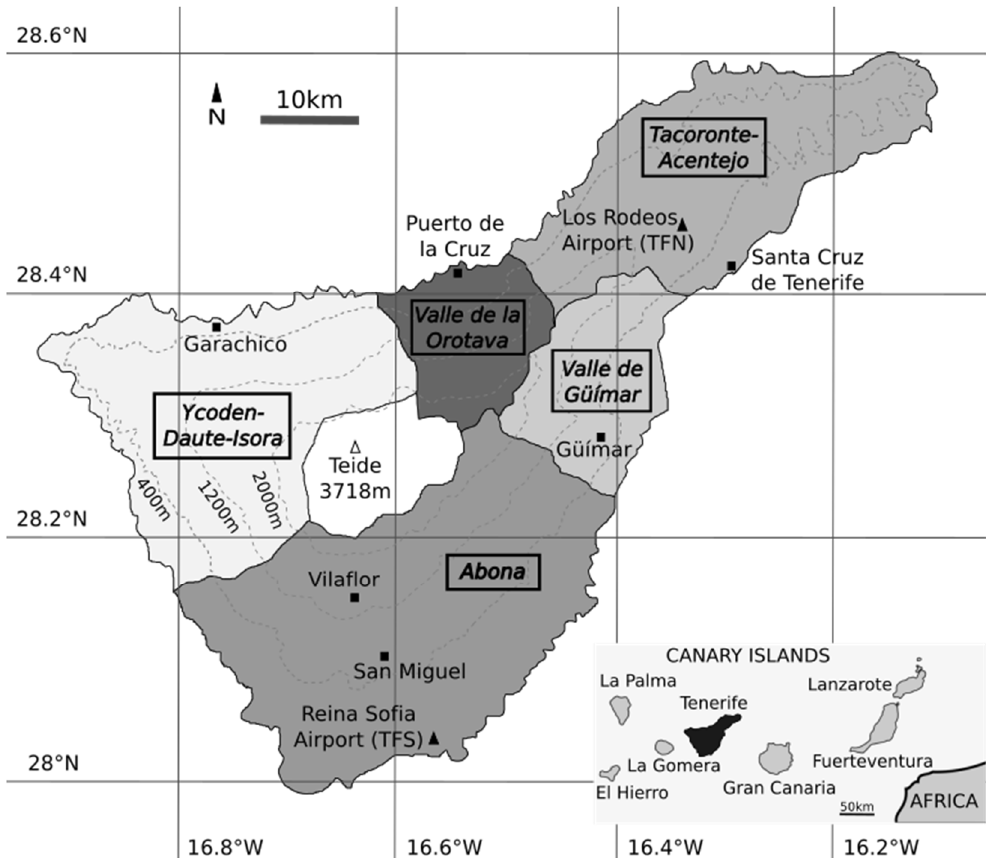
Figure 2. The island of Tenerife, Canary Islands (see inset), and the geographical boundaries of the five Denominación de Origen regions (DOs). Towns (squares) and geographical landmarks (triangles) in each are labelled. Table 1. Size, geography, varietals and economic contribution of each wine according to